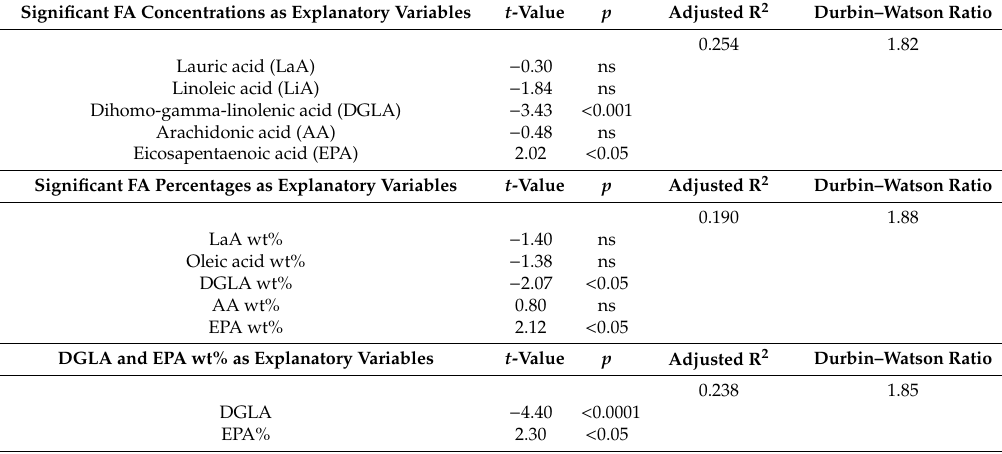
Table 4. Multiple linear regression analysis of the age at onset of ICH.